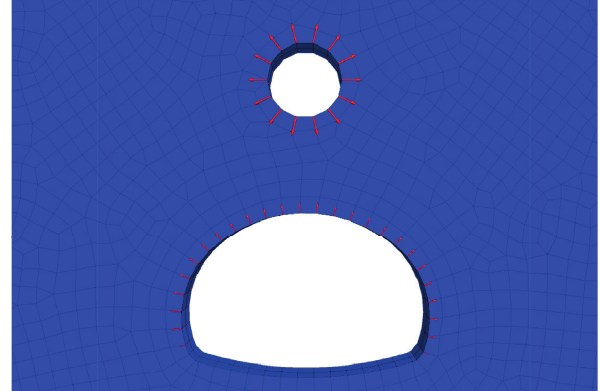
Figure 13: The fill material pressure and supporting pressure in the numerical model.